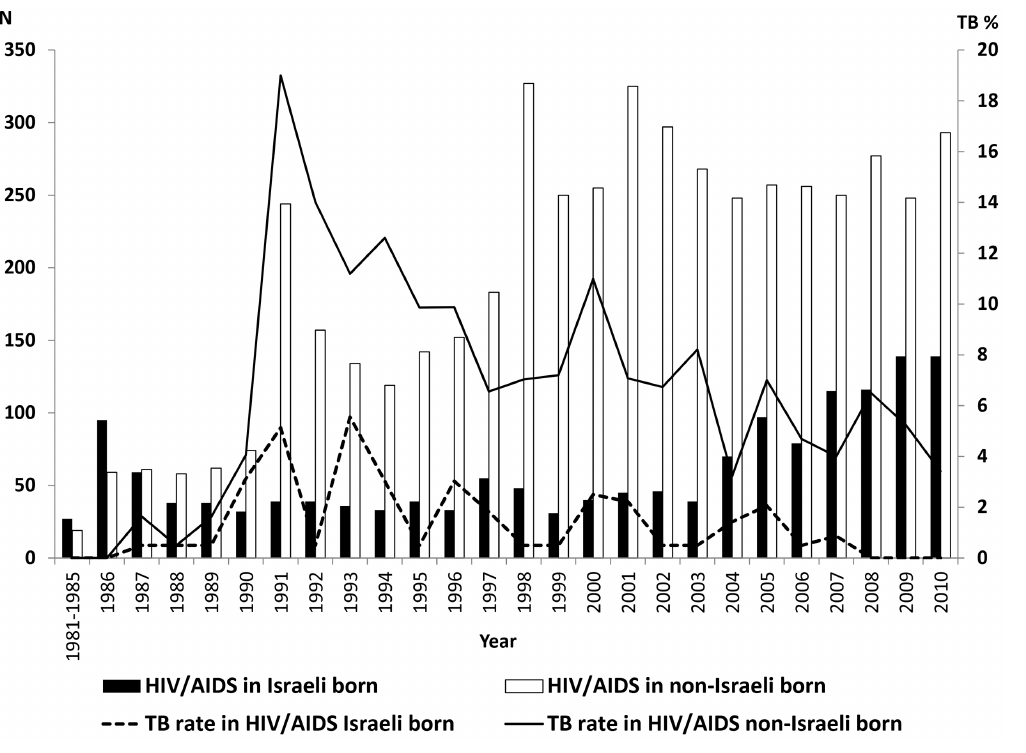
Figure 1. Newly reported HIV/AIDS in Israel and the proportion of tuberculosis among Israeli and non-Israeli born, 1983–2010. Capitation: The data were retried from the National tuberculosis and HIV/AIDS registries at the Israeli Ministry of Health, Jerusalem, Israel.